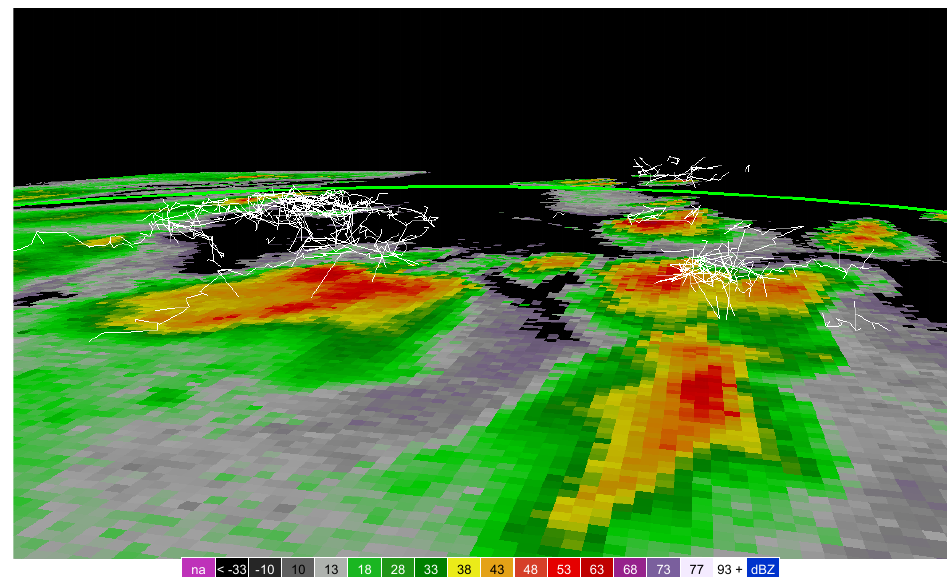
Figure 4. Side view of 3D lightning channels overlaid on composite reflectivity in WDSS − II at 2153 UTC 21 June 2016.